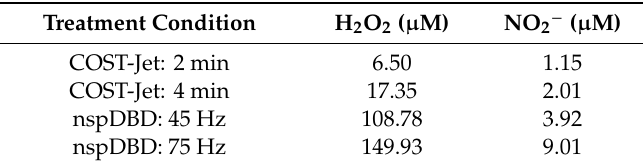
Table 2. Mock Treatment